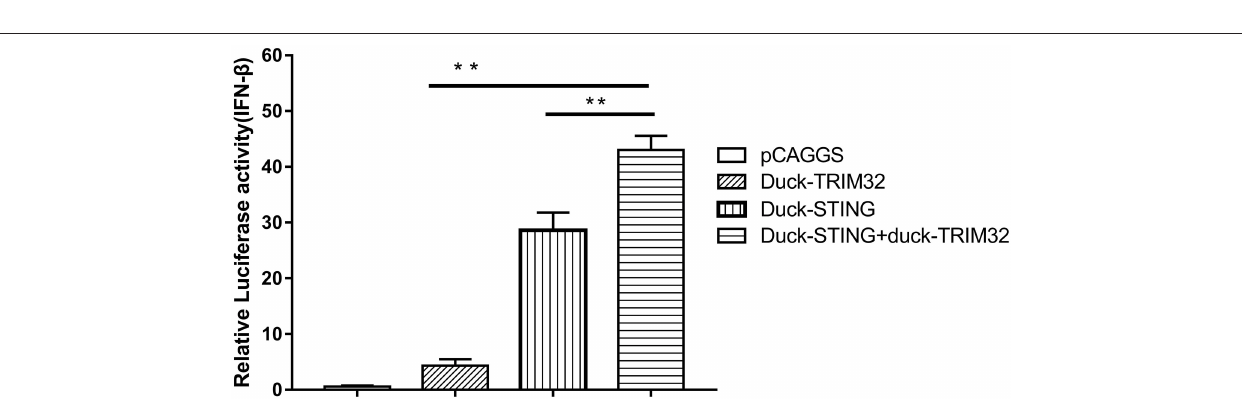
against viral infections. For example, TRIM5,